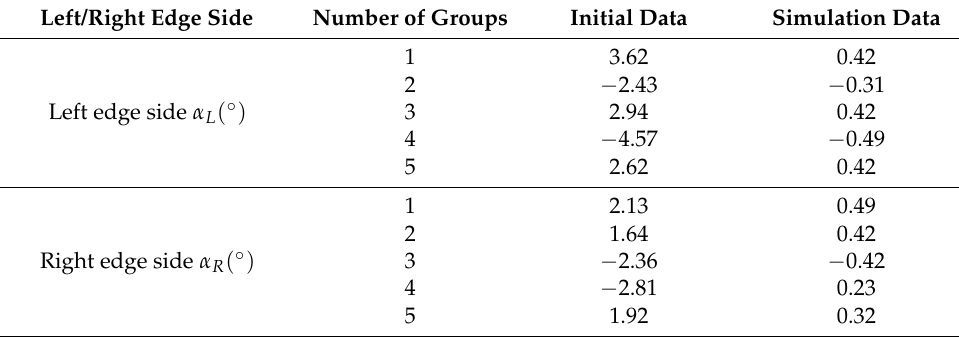
Table 2. Experimental data of declination angle of